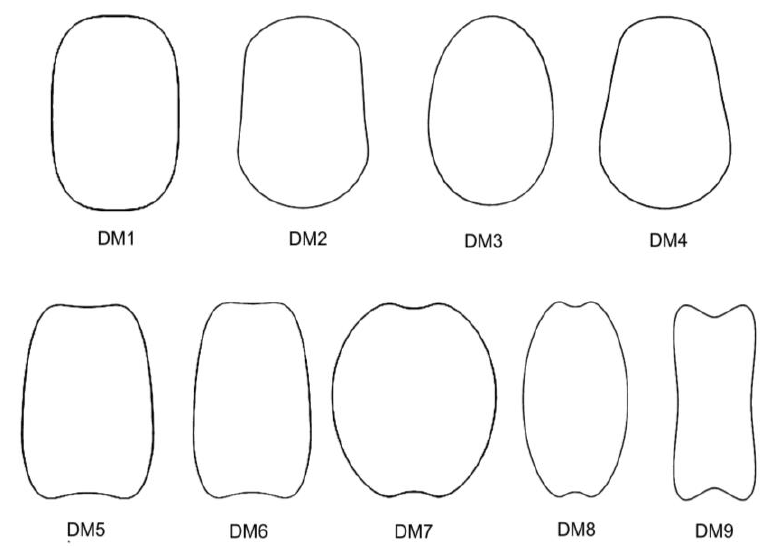
Figure 2. Dorsal models (DM) used in this work, taken from [16].